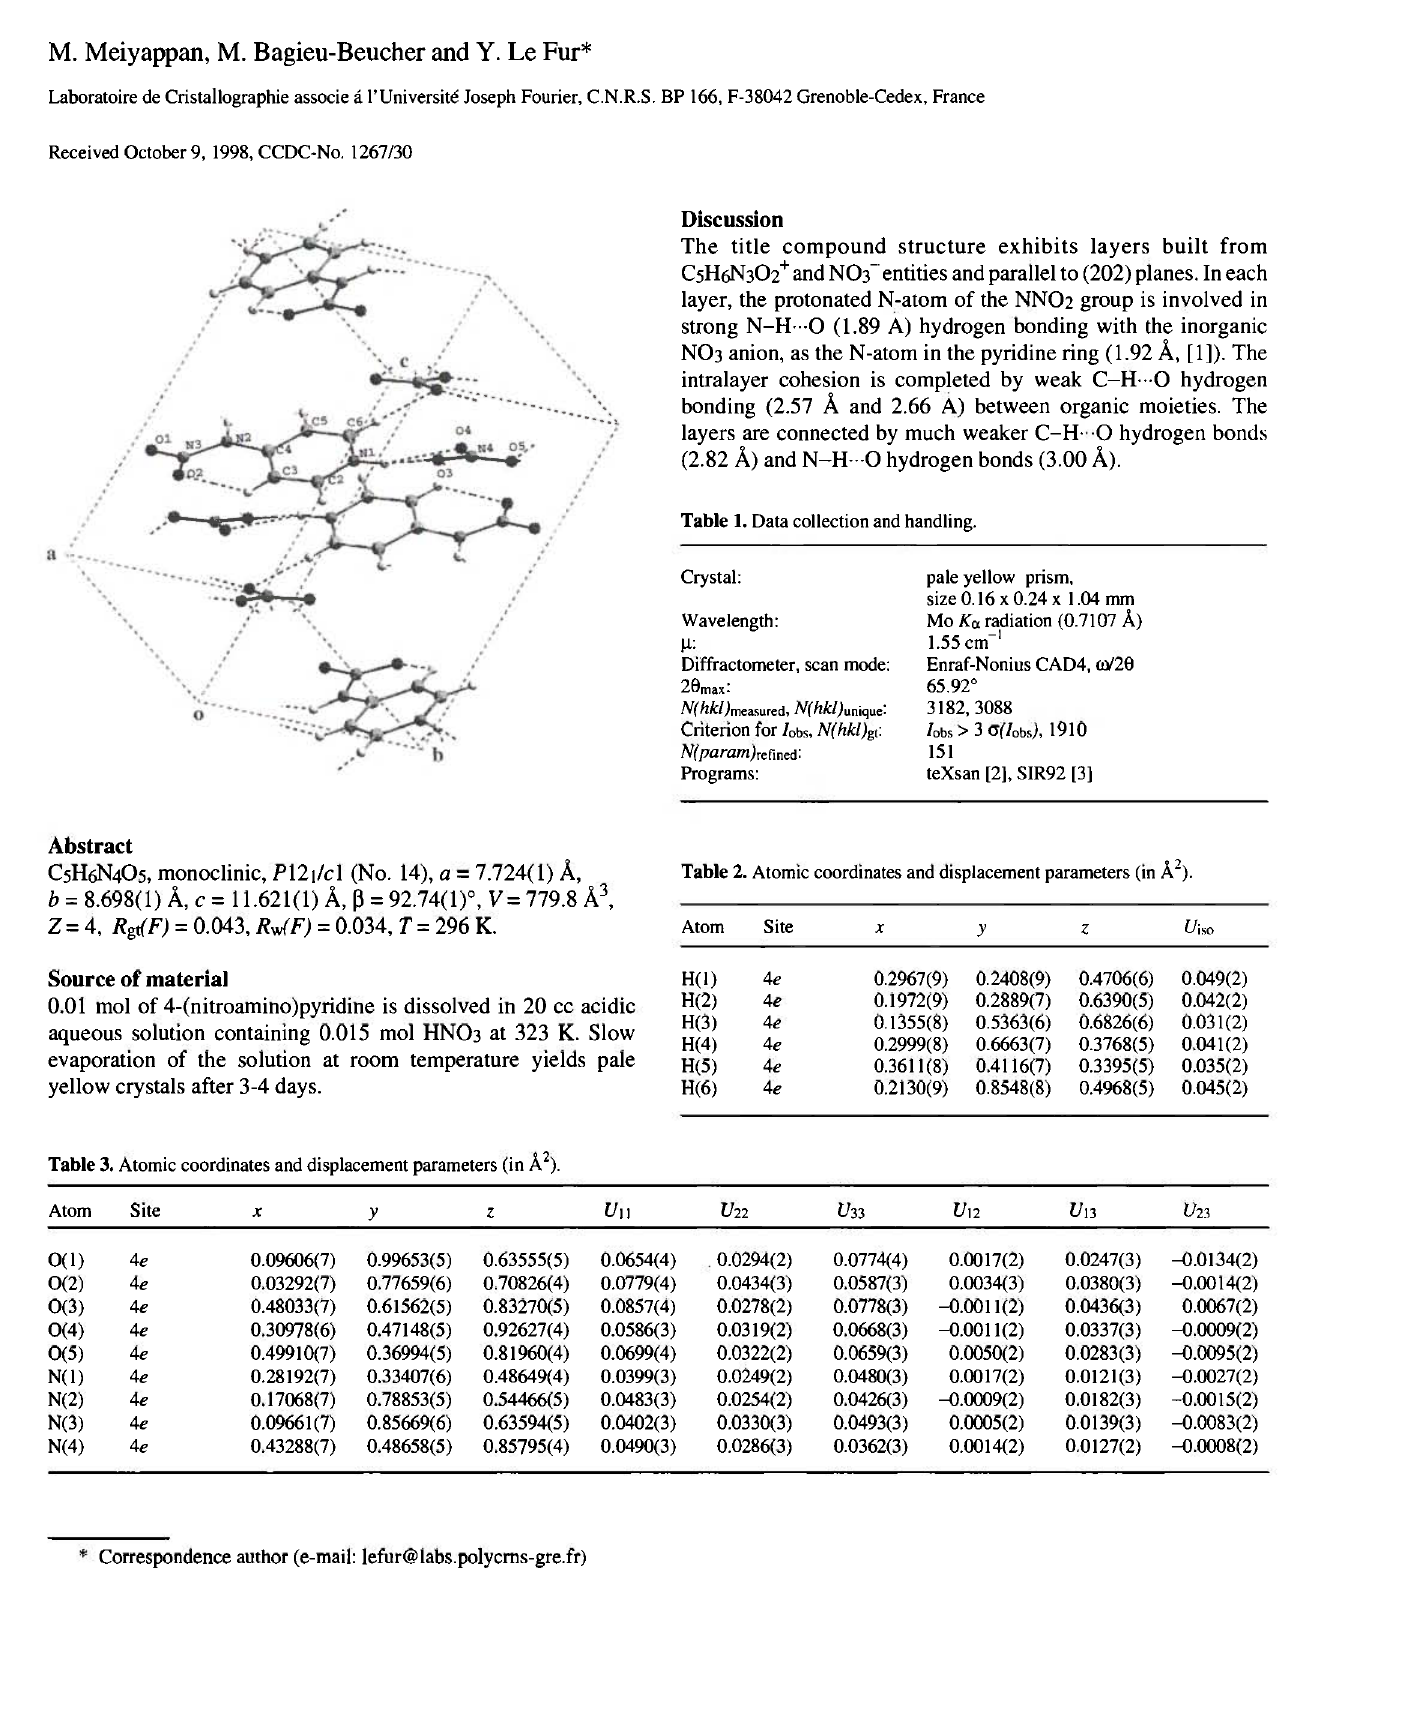
Table 1. Data collection and handling.